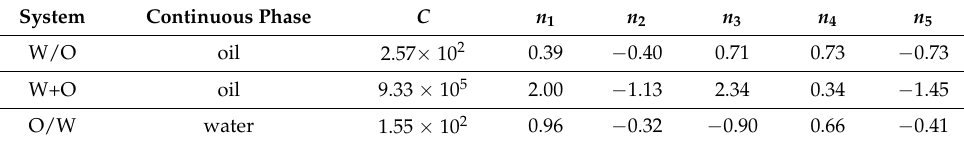
Table 1. Constants and exponents in Equation